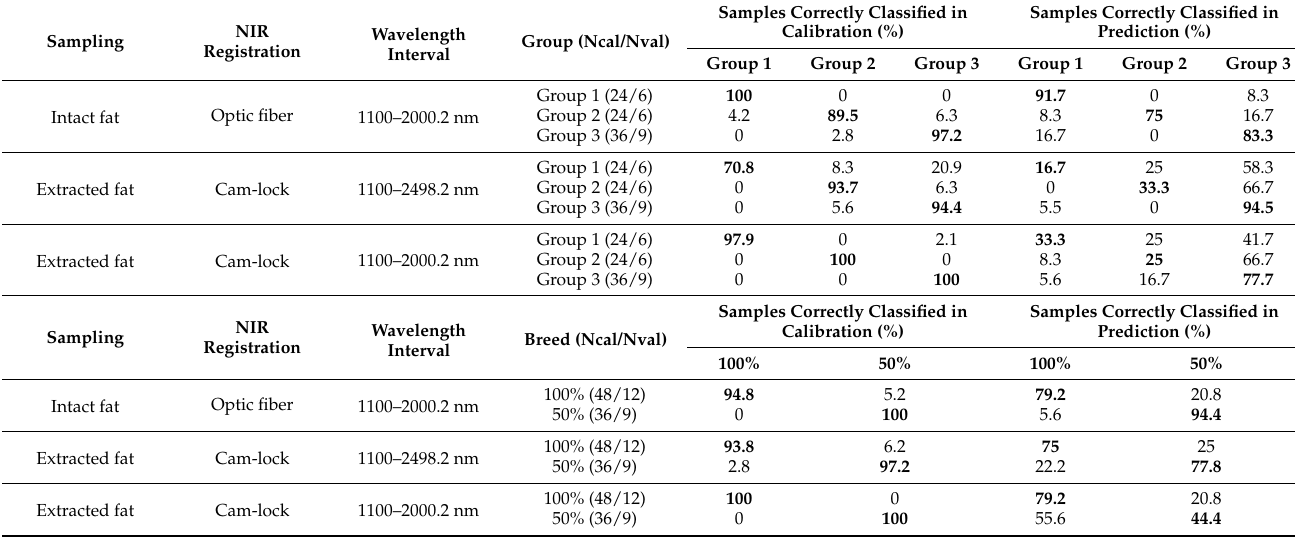
Table 2. Percentage of samples correctly classified (in bold) according to the days of montanera and breed by